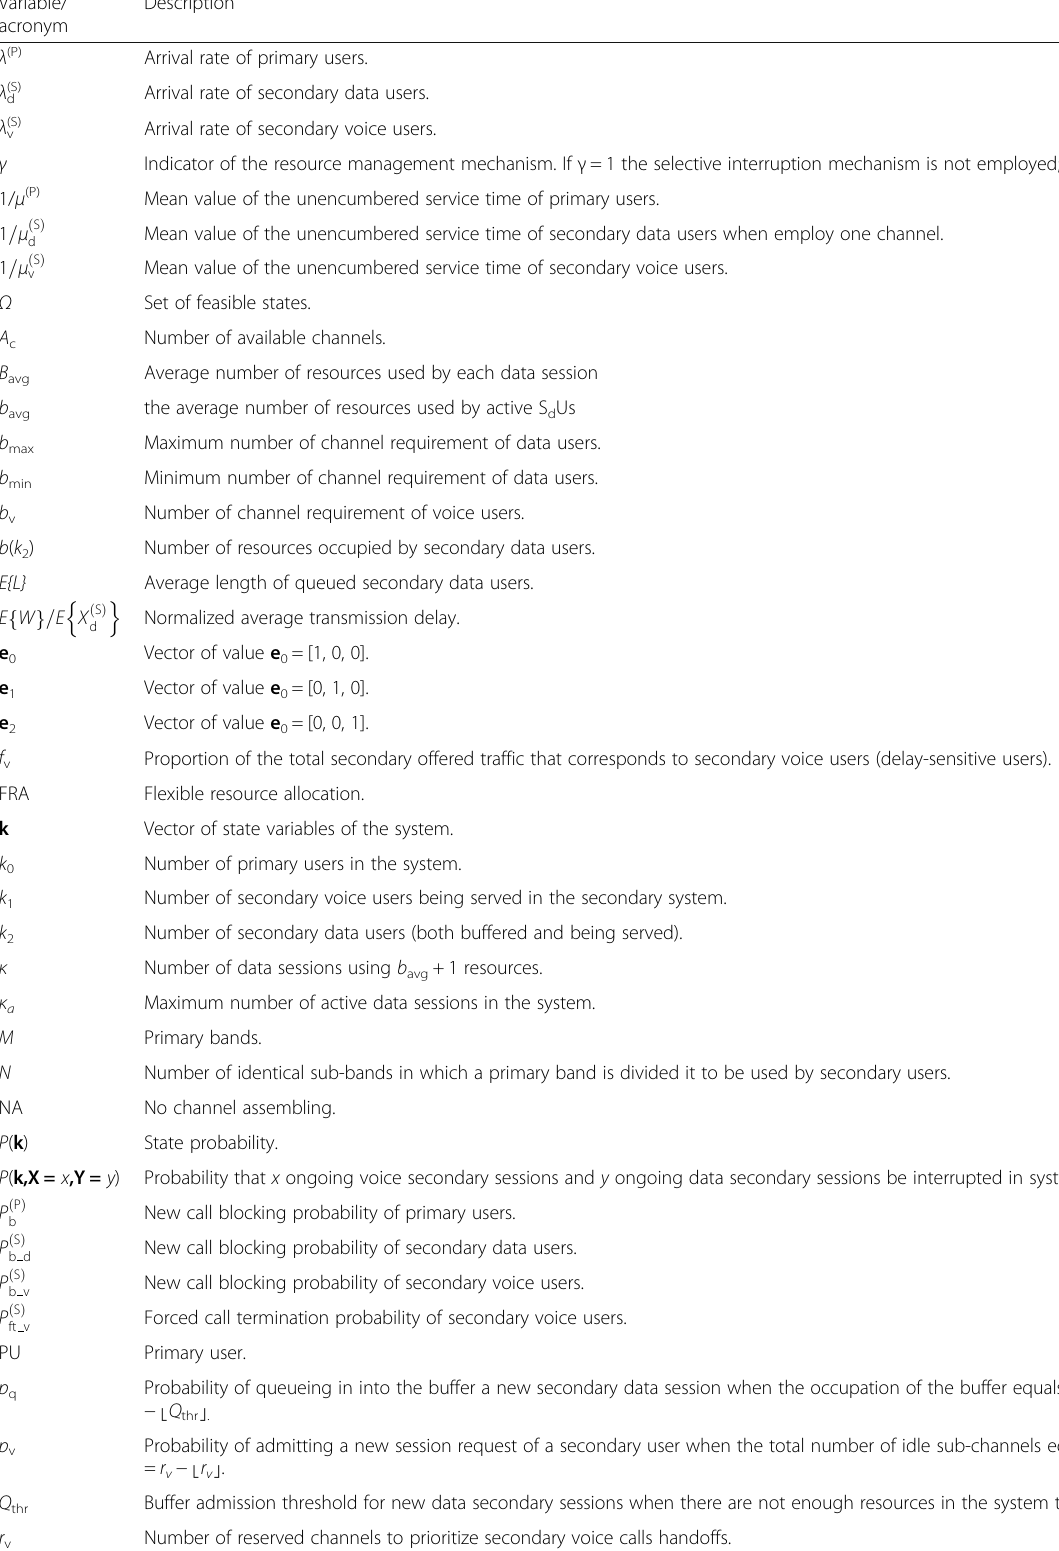
Table 1 List of variables and